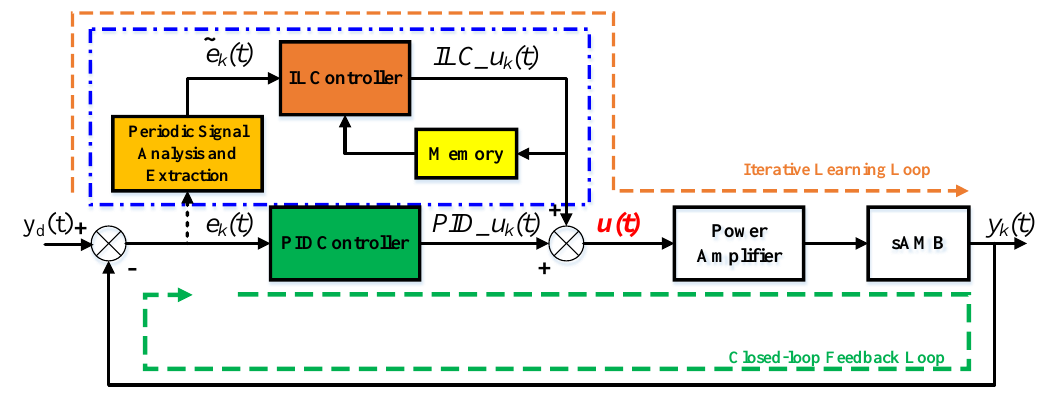
Figure 6. The parallel control system for UMP of the FHC AMB.